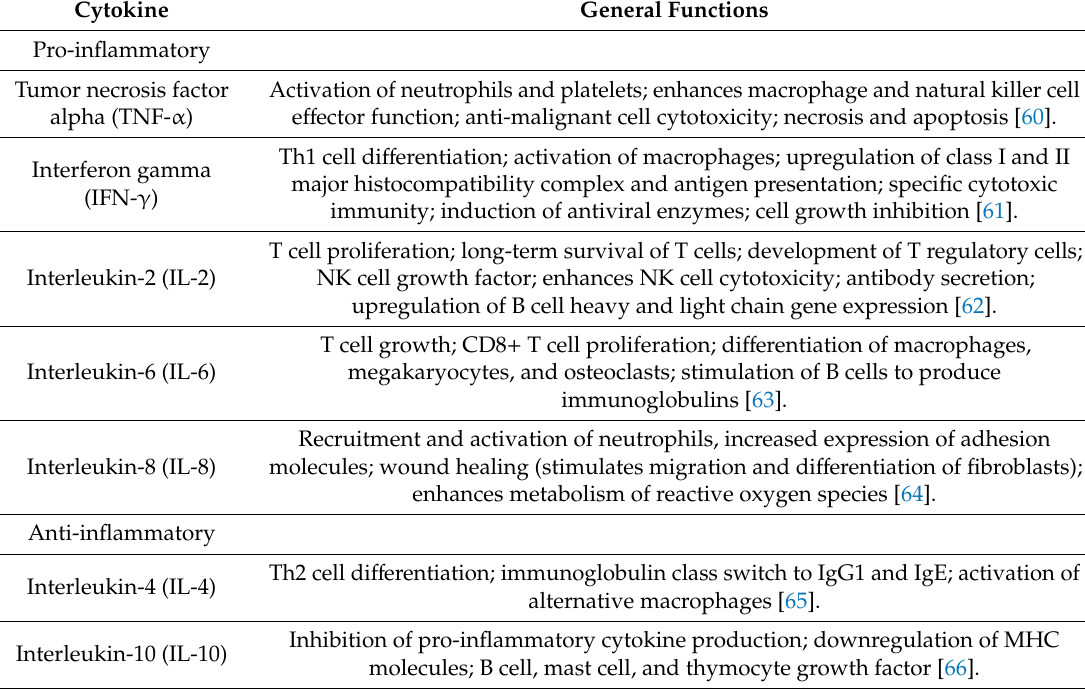
Table 1. Key cytokines involved in COVID-19 cellular invasion and function in the immune system. Cytokine General Functions